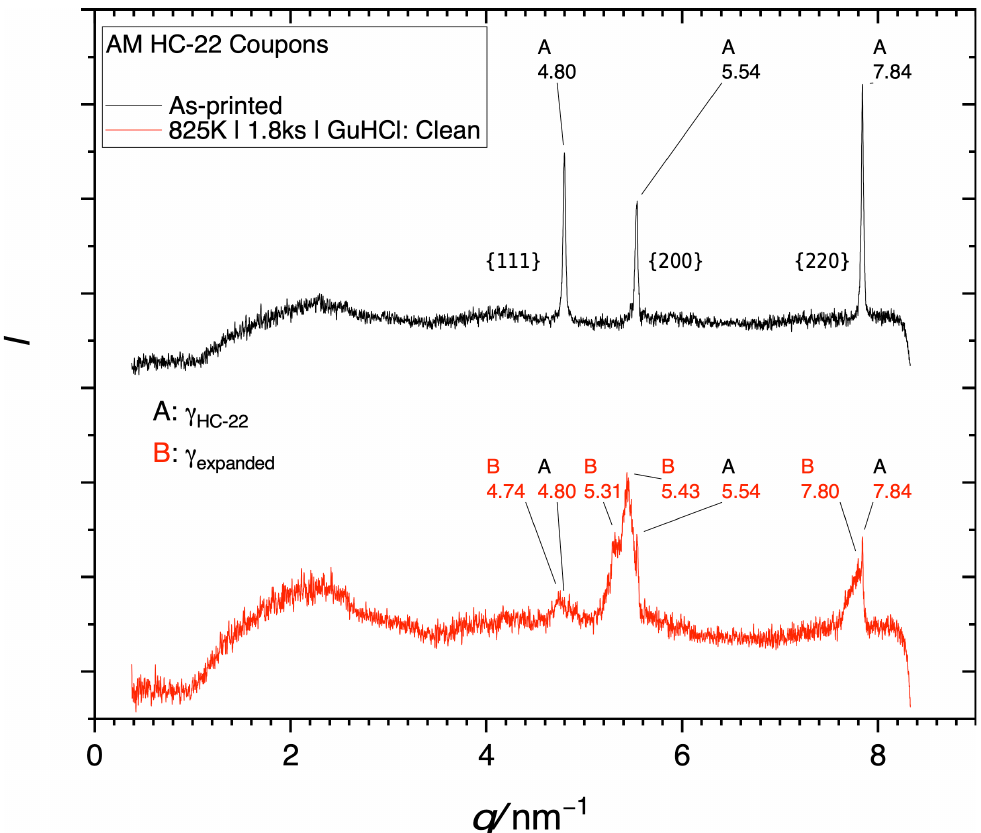
Figure 4. X-ray diffractogram of GuHCl coupons. To present these data independent of the wave- length of the X-ray source, the diffracted intensity is plotted against the spatial frequency q (not the Bragg angle θ B ). The number labels indicate specific spatial frequencies in nm − 1 . (A) Black: Diffractogram from the as-received alloy (B) Red: Diffractogram obtained after LTNC.